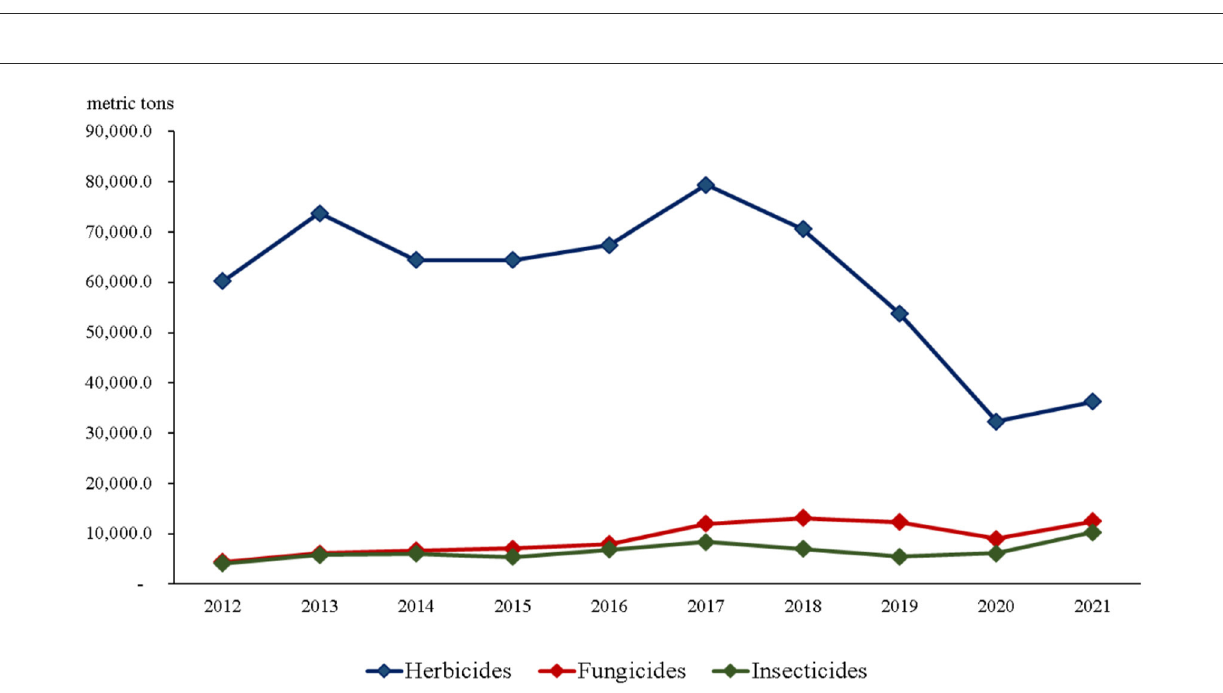
FIGURE2 Top three pesticides imported into Thailand from 2012 to